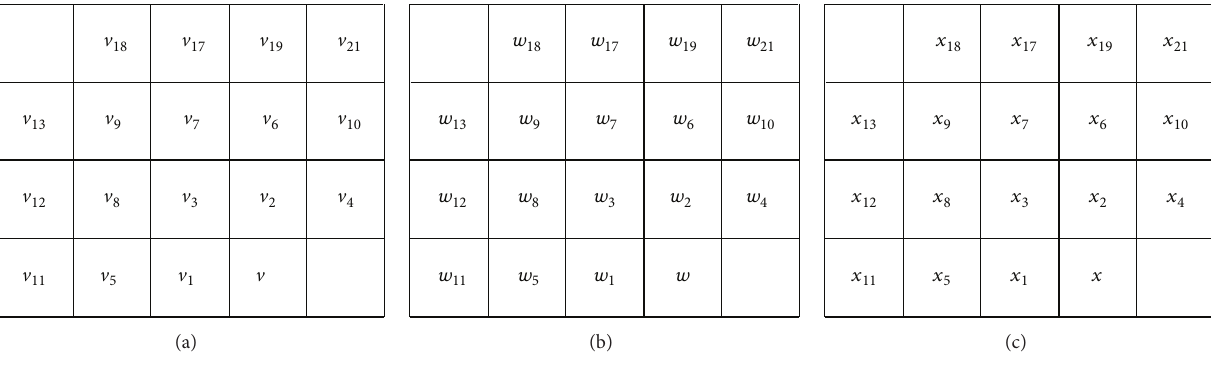
Figure 5: Definitions of context windows: (a) and (b) two previous bands, (c) current